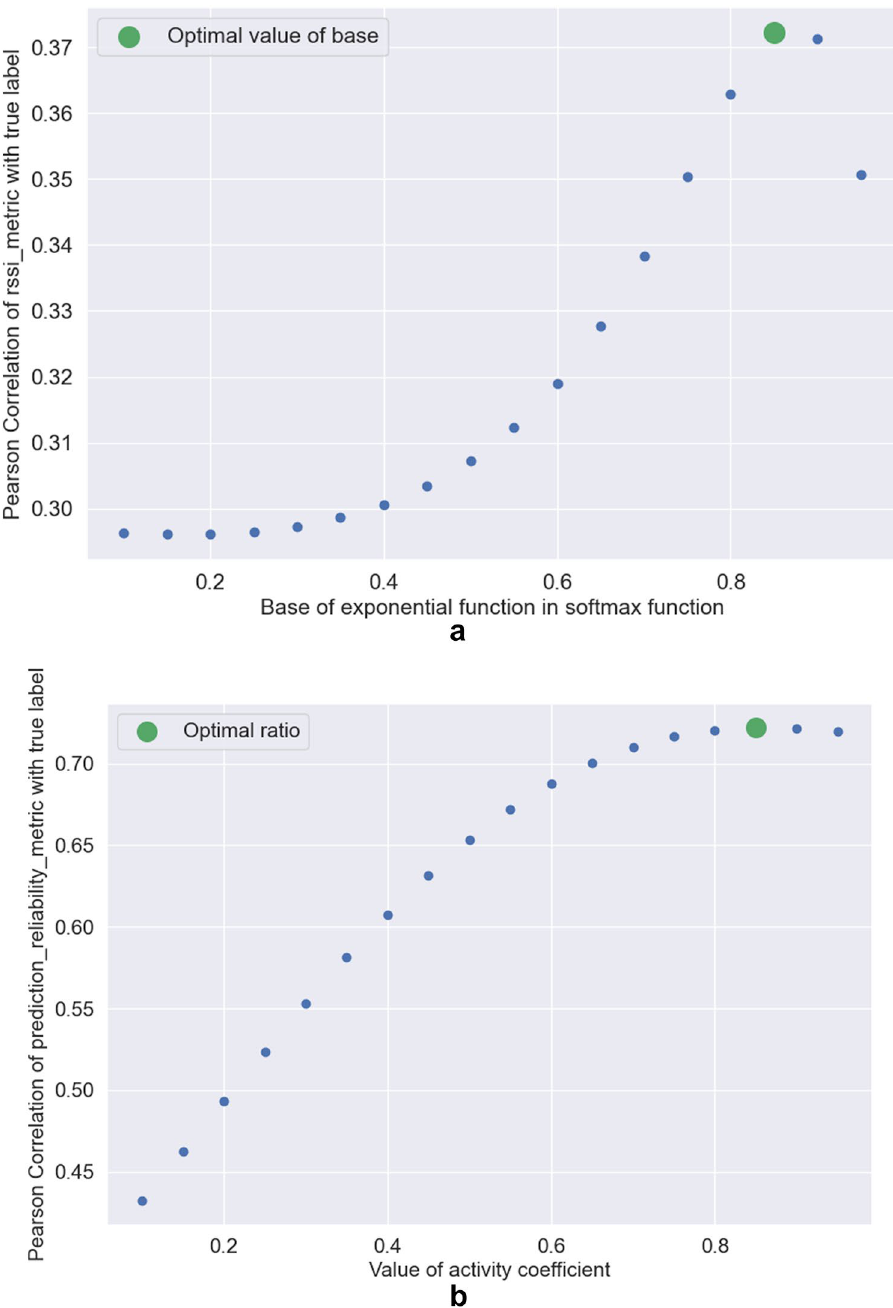
Figure 5. Determining the optimal values of parameters: ( a ) exponent base used in the softmax function; ( b ) importance coefficient used for activity_metric